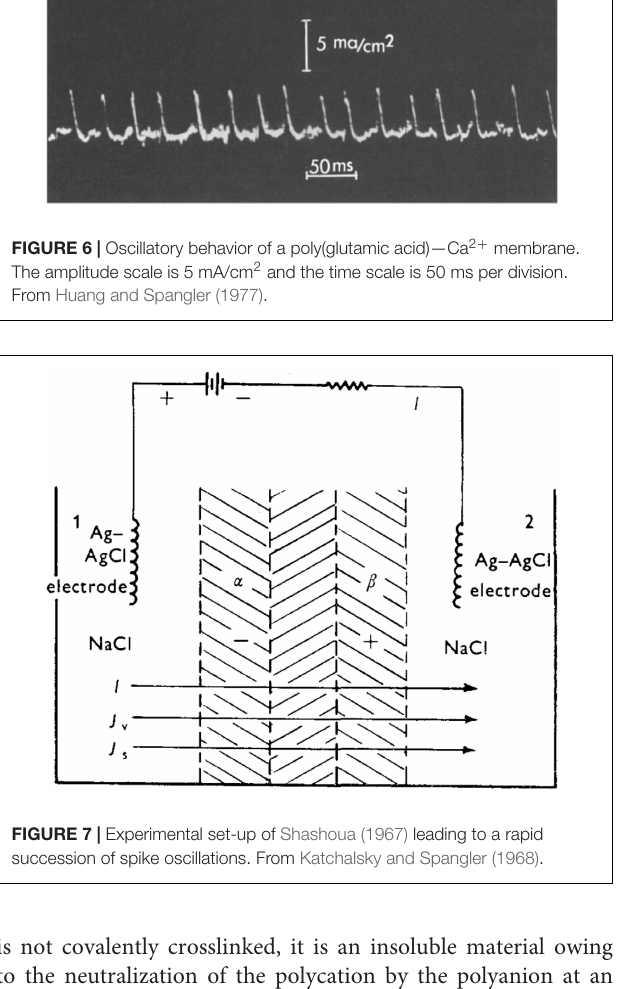
is not covalently crosslinked, it is an insoluble material